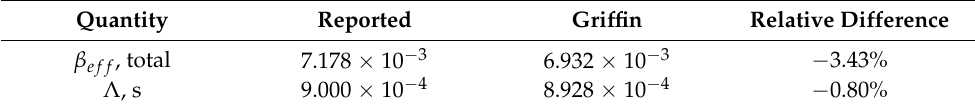
Table 7. Comparison of the reported and simulated kinetic parameters for TREAT. Quantity Reported